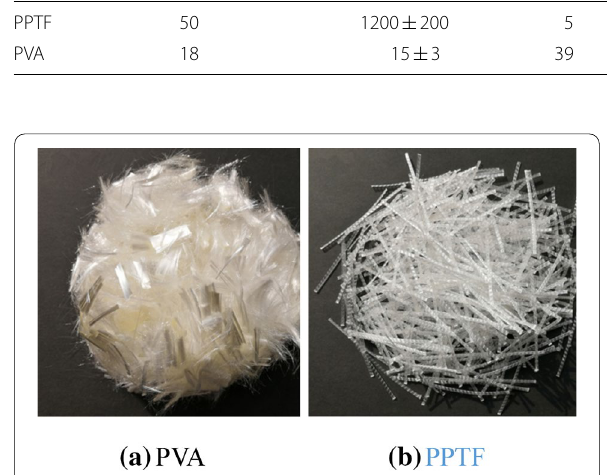
Fig. 1 Physical appearance of the two fibers a PVA b PPTF.